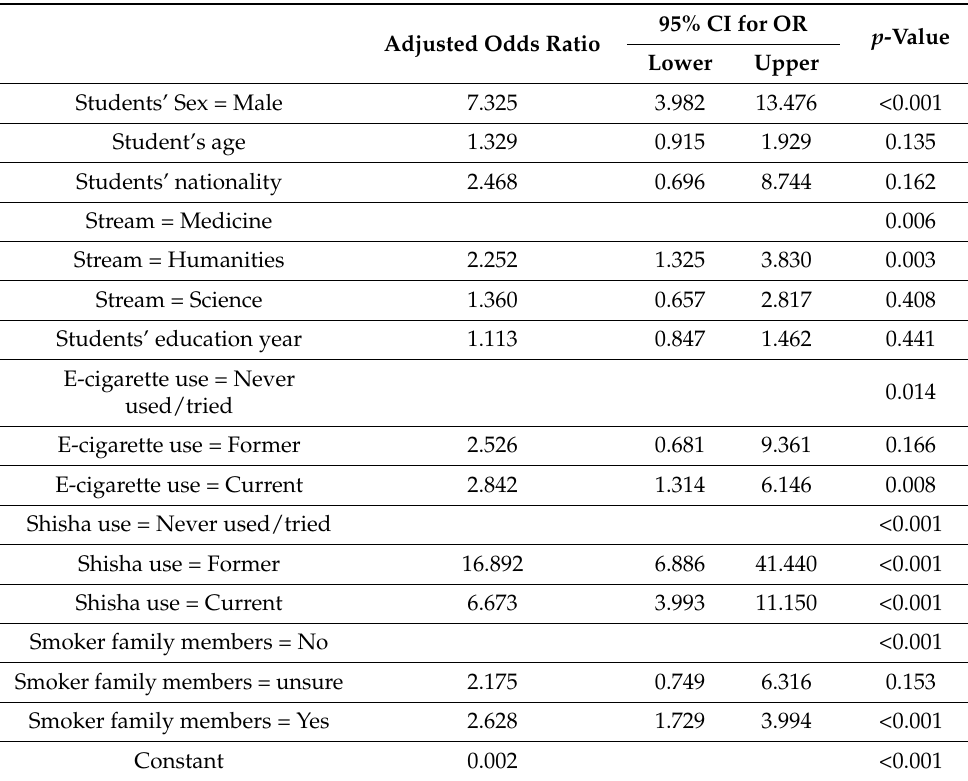
Table 4. Multivariate logistic binary regression analysis of university students’ smoking behaviors. N =